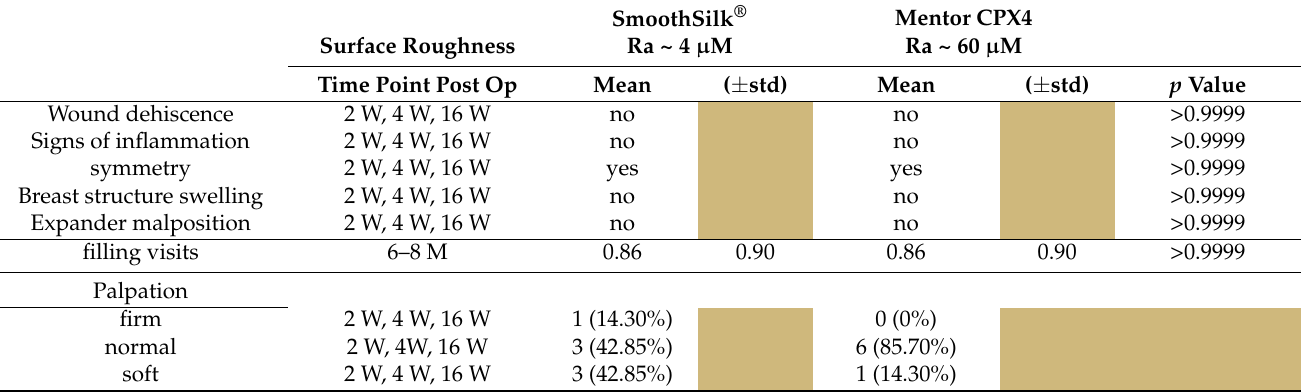
Table 5. Clinical evaluation of tissue expander performance 2 W, 4W, and 16 W post-device